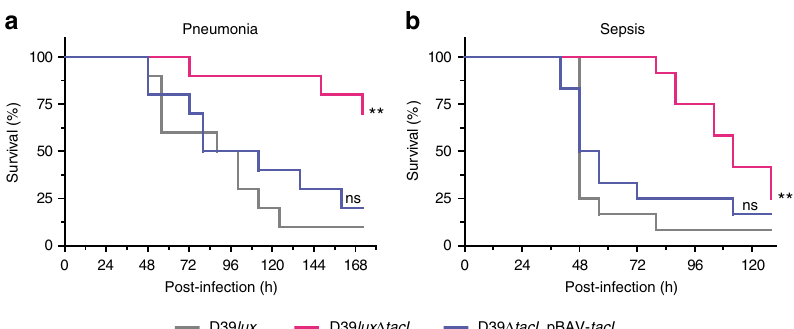
Fig. 5 Impact of TacL de fi ciency on pneumococcal virulence. Survival of CD-1 mice after a intranasal infection with ~2.5 × 10 7 bioluminescent S. pneumoniae D39 lux wild type, D39 lux Δ tacL , or the complemented mutant (D39 Δ tacL pBAV- tacL ) in the pneumonia model ( n = 10) (see also Supplementary Fig. 14 for bioluminescence images). b Survival of CD-1 mice ( n = 12) after intraperitoneal infection with ~3 × 10 3 pneumococci in the systemic infection model. ** p < 0.01; ns not signi fi cant (Log-rank (Mantel –